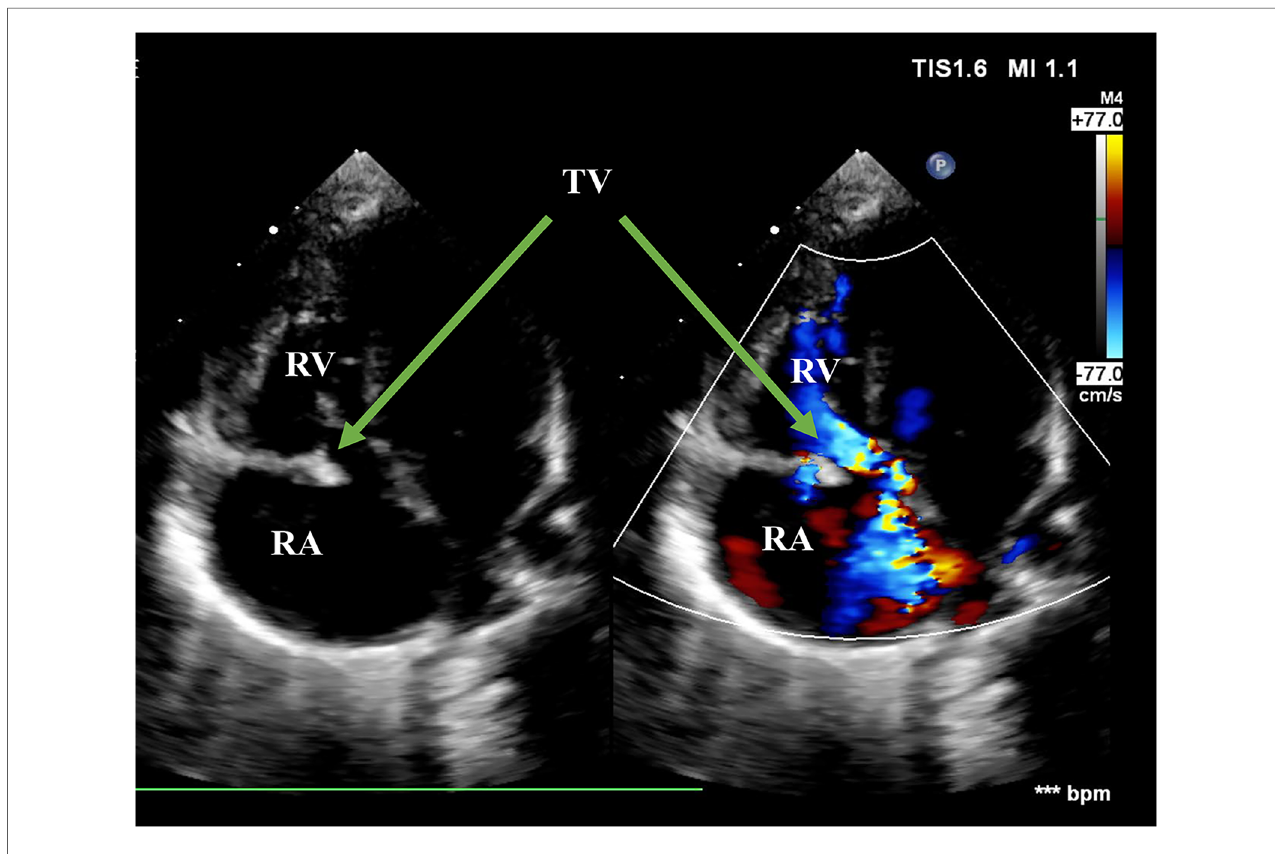
FIGURE 2 Echo before surgery in the A4C view. The picture showed fl ailed anterior lea fl et prolapsing into the right atrium with a hyperechogenic mass. The green arrows pointed at fl ailed anterior lea fl et of the tricuspid valve. RA, right atrium; RV, right ventricle; TV, tricuspid valve; A4C, apical four-chamber.